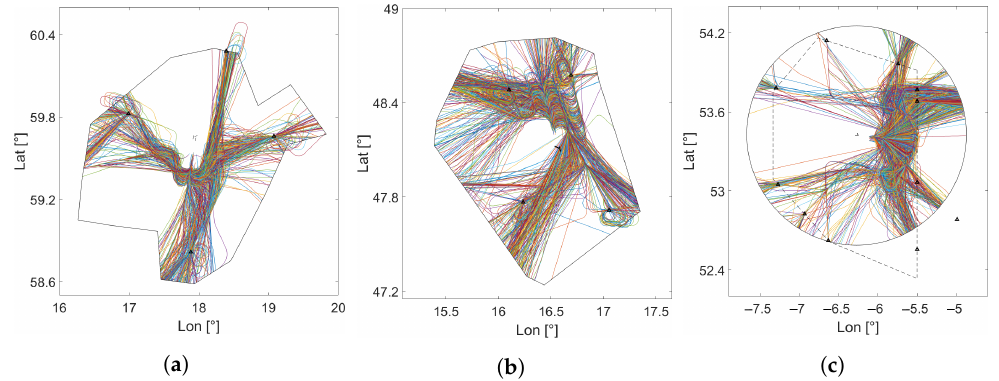
Figure 1. Trajectories of the October 2019 TT datasets for Arlanda runway 01R ( a ), Vienna runway 16 ( b ) and Dublin runway 28L ( c ).